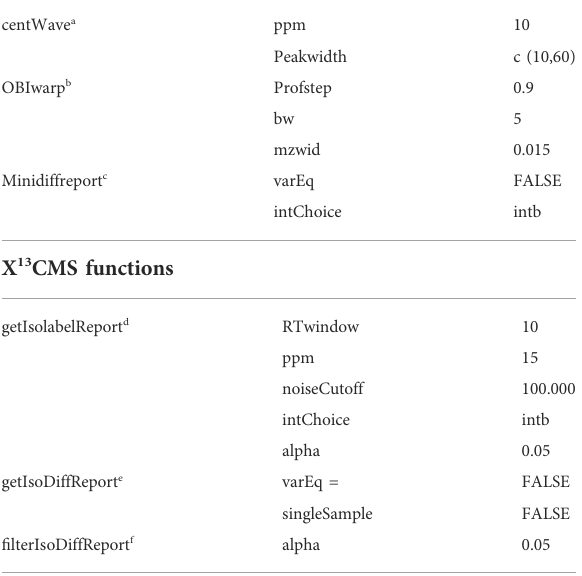
TABLE 1 Parameter non-targeted